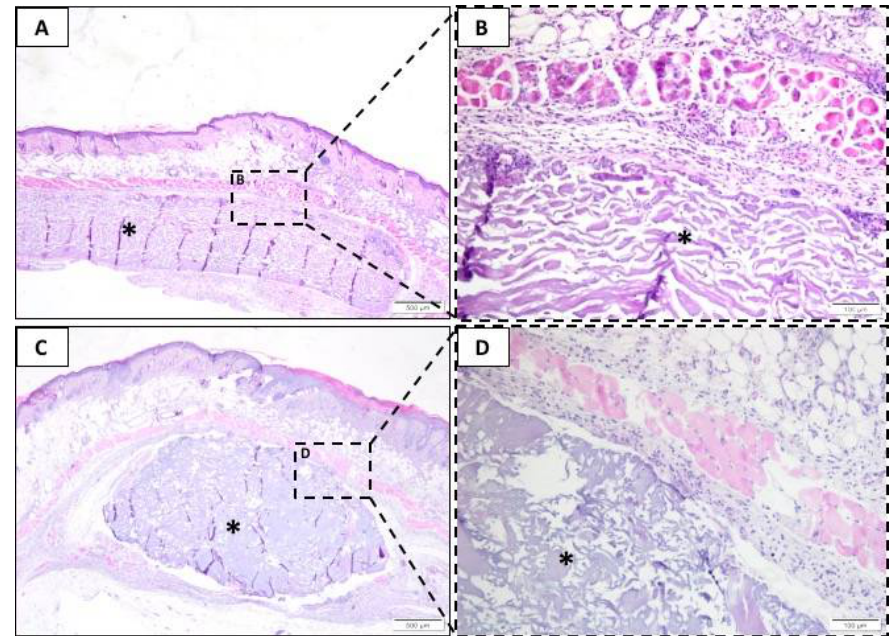
Figure 2. Representative photomicrographs of subcutaneous injury after seven days. Histological section stained with hematoxylin/eosin from the incision region in the BG groups ( A , B ) and LT groups ( C , D ). The area occupied by the membrane is indicated by an asterisk (*). ( A , C ) 40× magnification, scale bar: 500 µm; ( B , D ) 200× magnification, scale bar: 100 µm. Membranes 2020 , 10 , x FOR PEER REVIEW